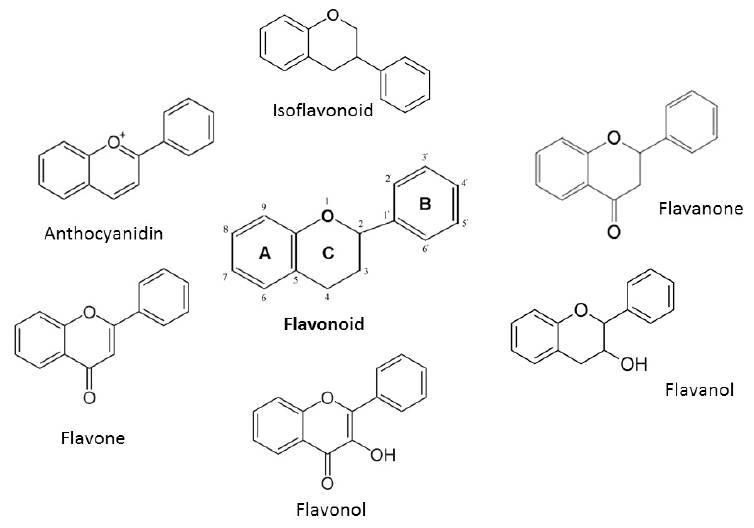
Figure 1. Main chemical structures of flavonoids.